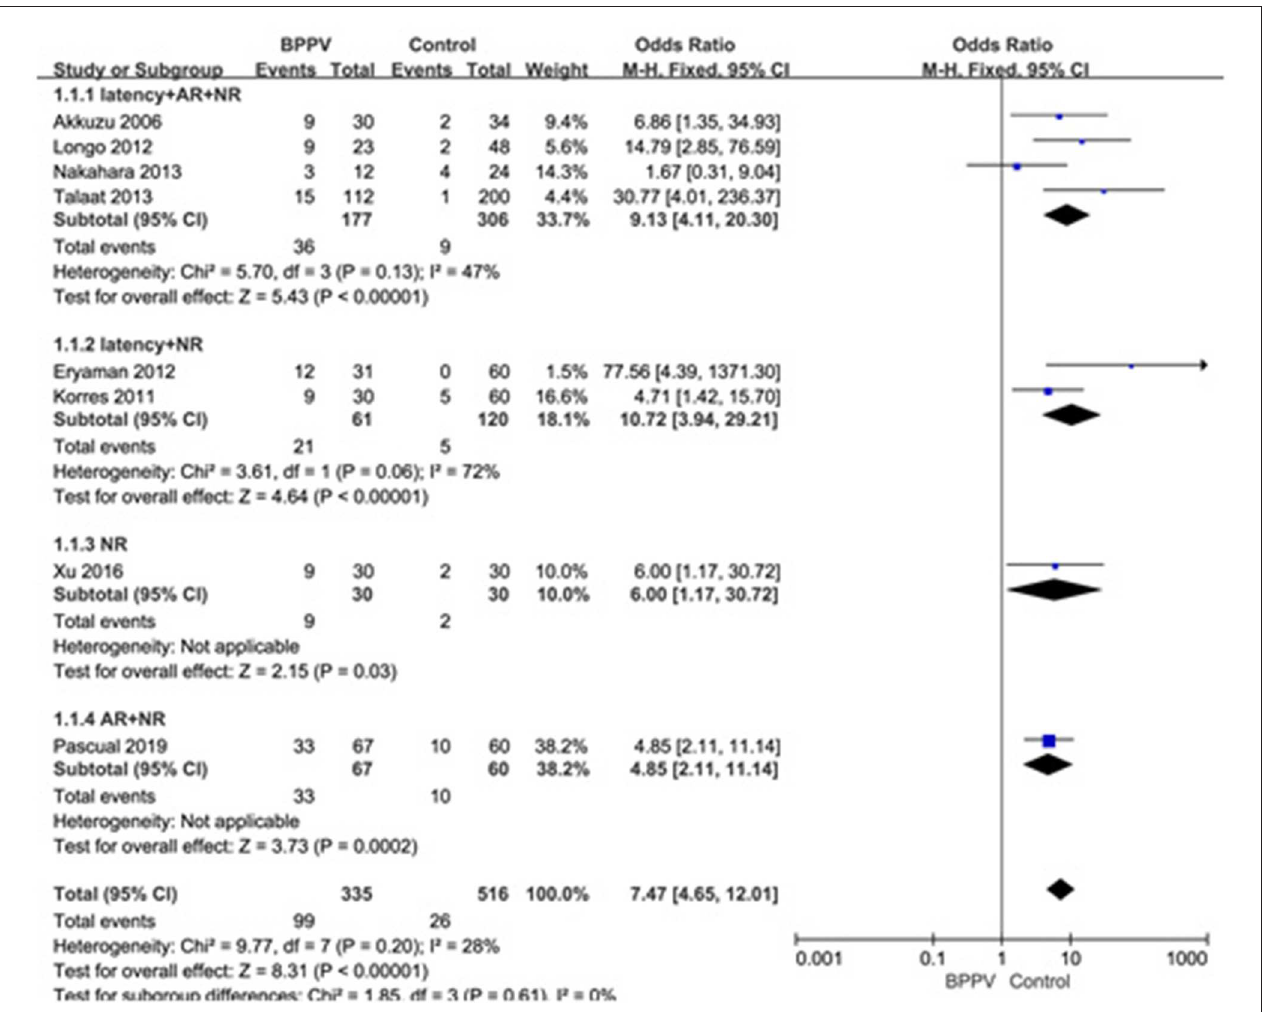
FIGURE 8 | Forest plots of subgroup meta-analysis of proportion of abnormal cVEMP based on the different diagnostic criteria of abnormal cVEMP. BPPV, benign paroxysmal positional vertigo; cVEMP, cervical vestibular evoked myogenic potential; AR, asymmetry ratio; NR, no response.